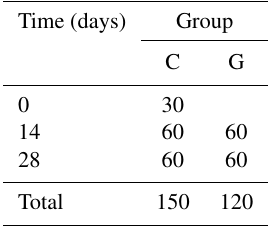
Table 1. Experimental set-up (number of